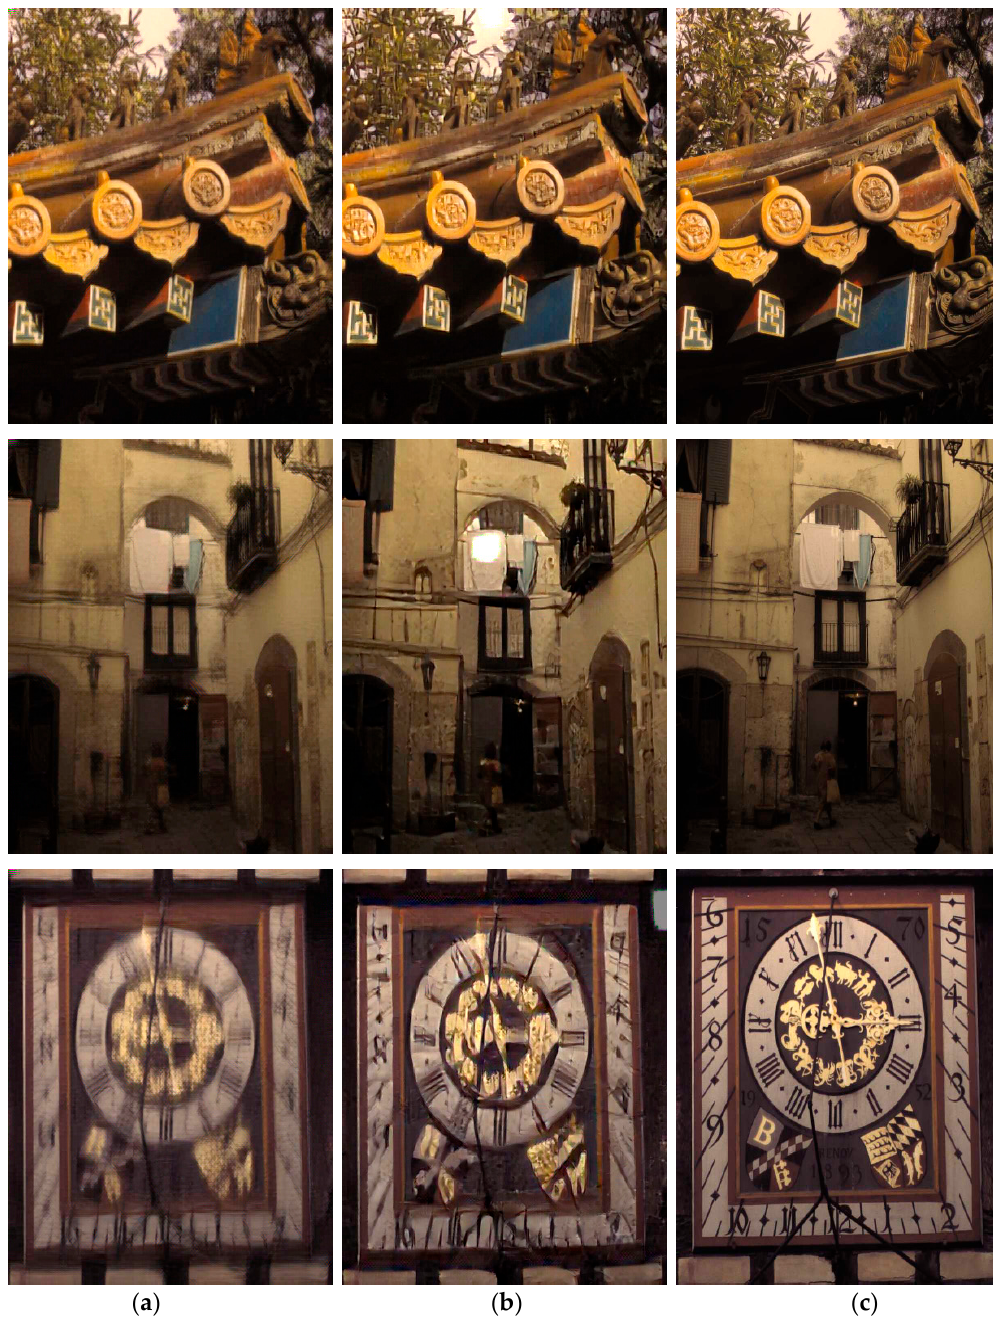
Figure 21. Generated images from comparing proposed method with WGAN-GP using content loss method on Kohler dataset: ( a ) WGAN with content loss ( b ) Proposed method ( c ) Original sharp image.